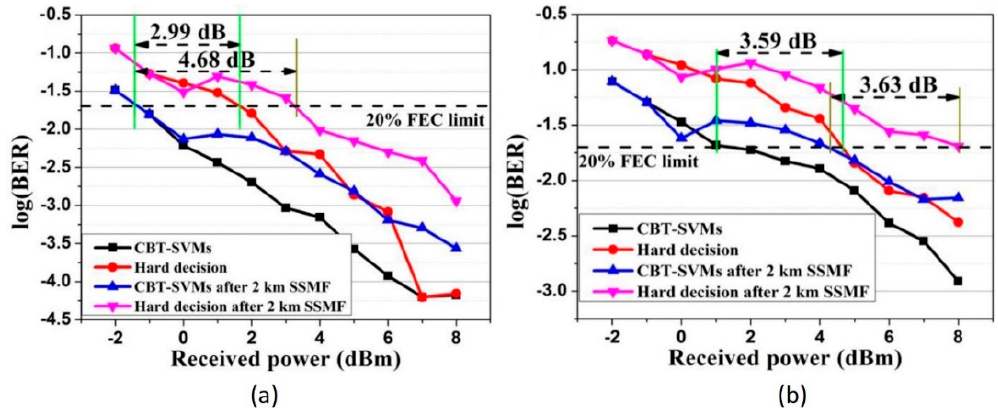
Figure 18. BER curves for ( a ) 40 Gbps and ( b ) 50 Gbps PAM4 signal using CBT-SVMs (reprinted from [42] with permission from IEEE).